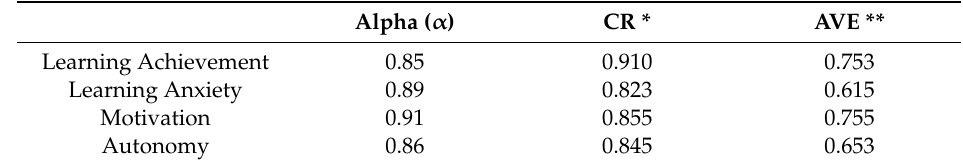
Table 2. Reliability and validity indices.